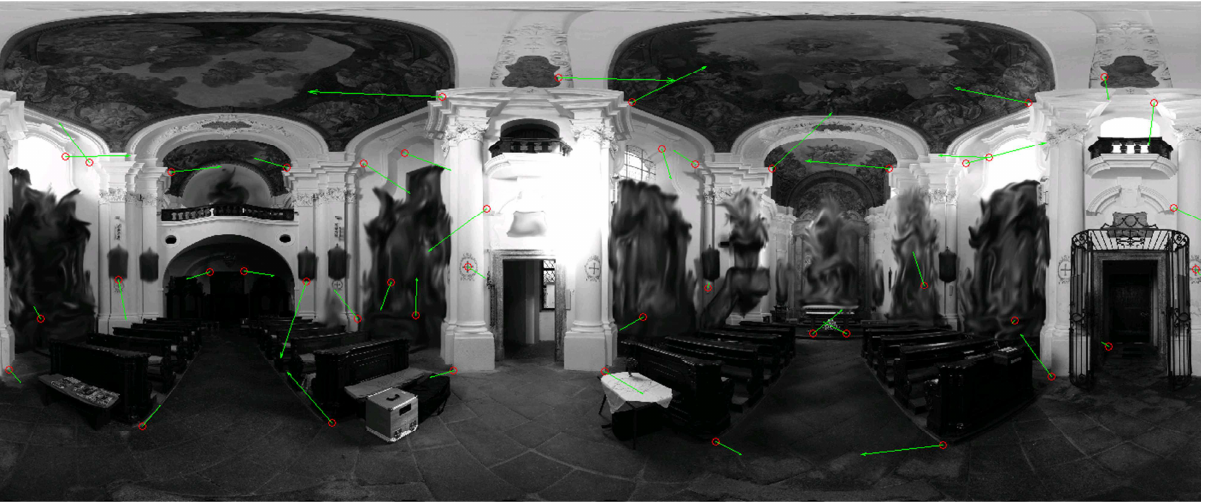
Figure 9. Estimated residuals (green arrow) between image coordinates of the features in panoramic coordinate system (red circle) and adjusted value of the features (green arrowhead) after adjustment. The real value of estimated residuals is very small and was therefore scaled to 1:50. The visual examination of residual vectors does not indicate systematic